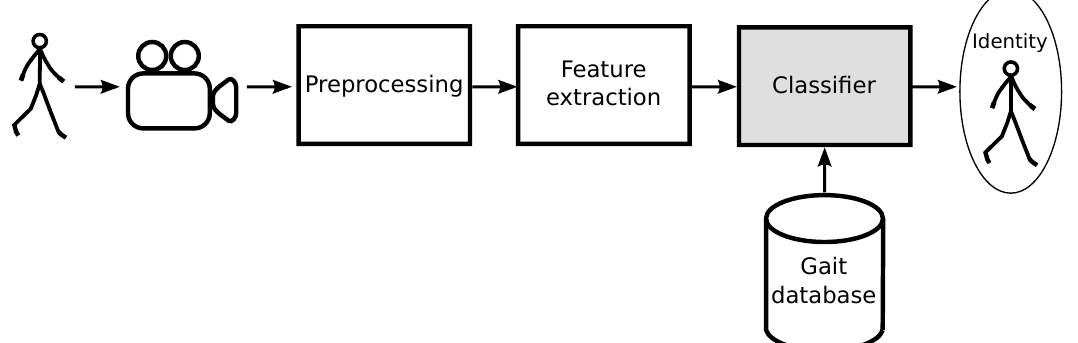
Figure 1. Structure of a gait recognition